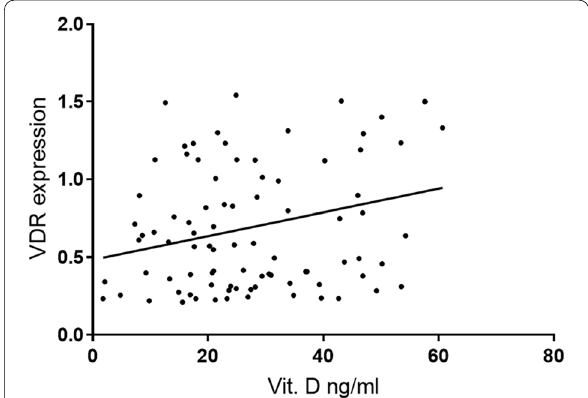
Fig. 1 Pearson’s correlations test of serum vit. D with VDR expression showing positive correlation